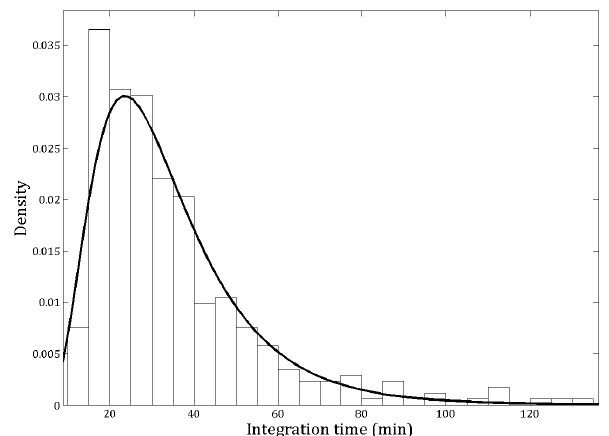
Fig. 6. Integration time distribution of the vertical profiles of water Figure 6. Integration time distribution of the vertical profiles of water vapor mixing ratio. The 2 vapour mixing ratio. The bold black line represents a log-normal fit bold black line represents a log-normal fit of the distribution which represents an adequate 3 of the distribution which represents an adequate approximation of approximation of the histogram. 4 the histogram.